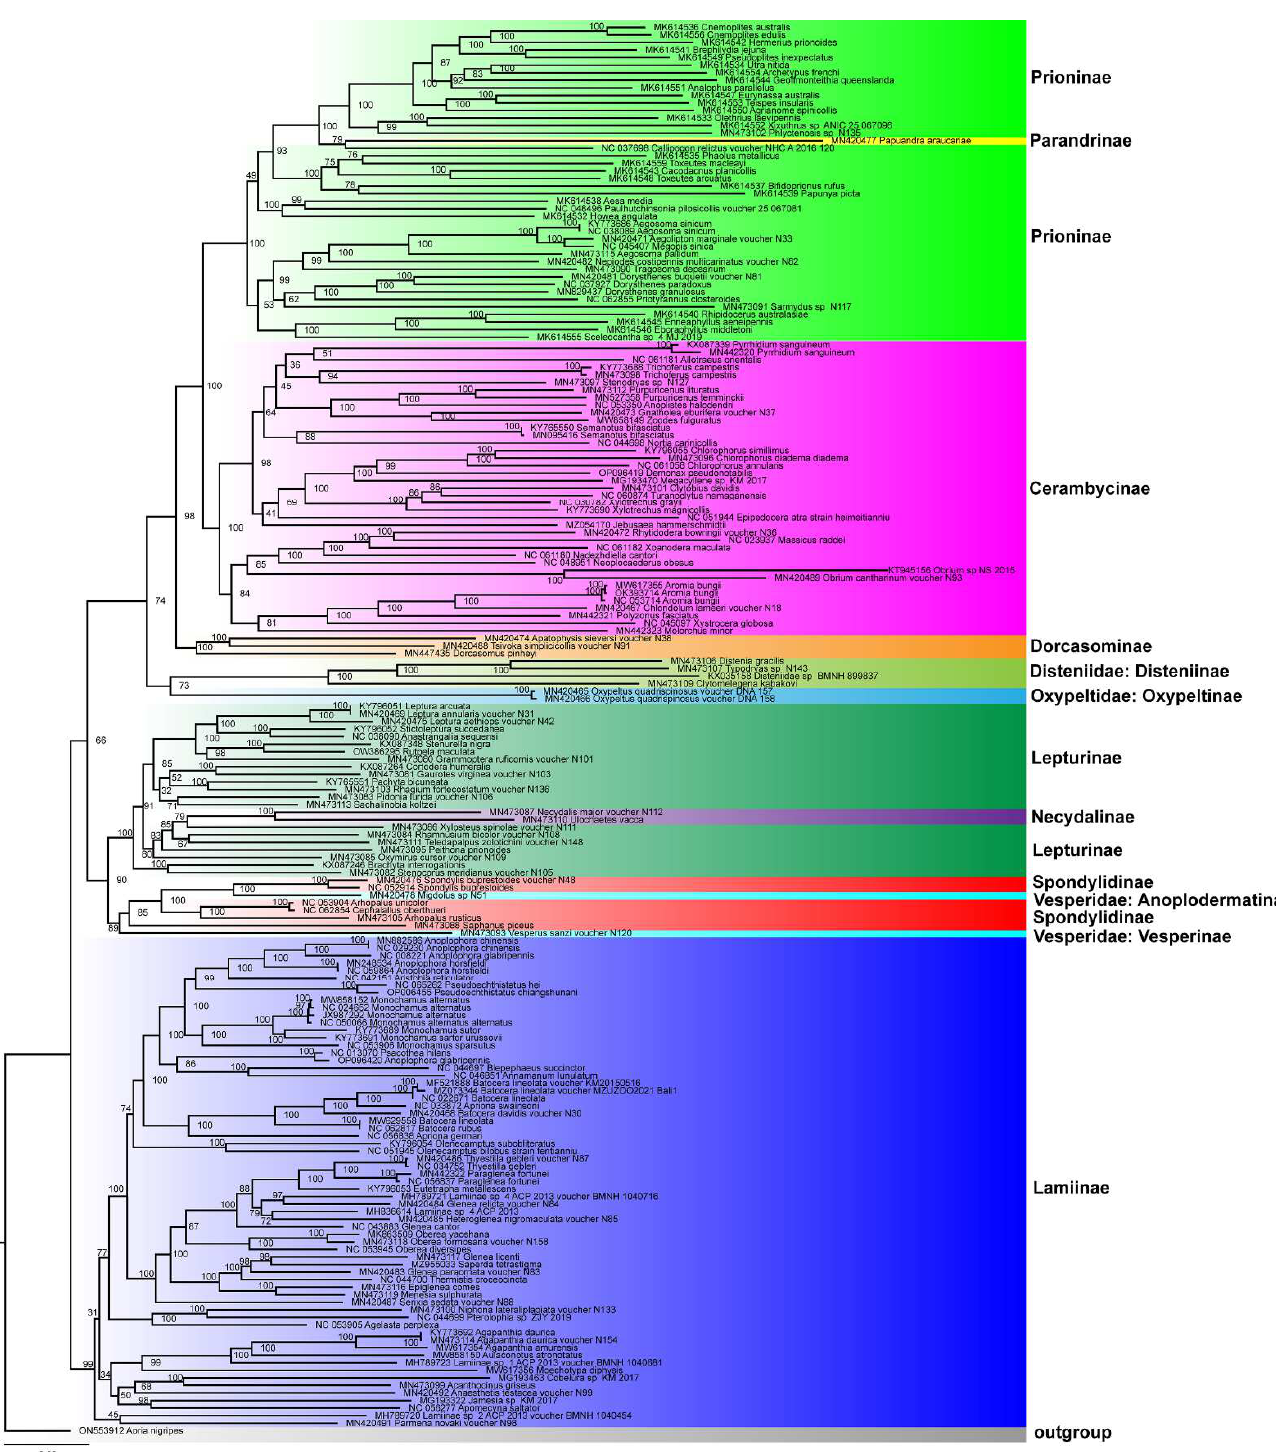
Figure 5. Maximum-likelihood phylogeny of Cerambycidae s.l. inferred from mitogenomic data. Numbers at the nodes are bootstrap values.